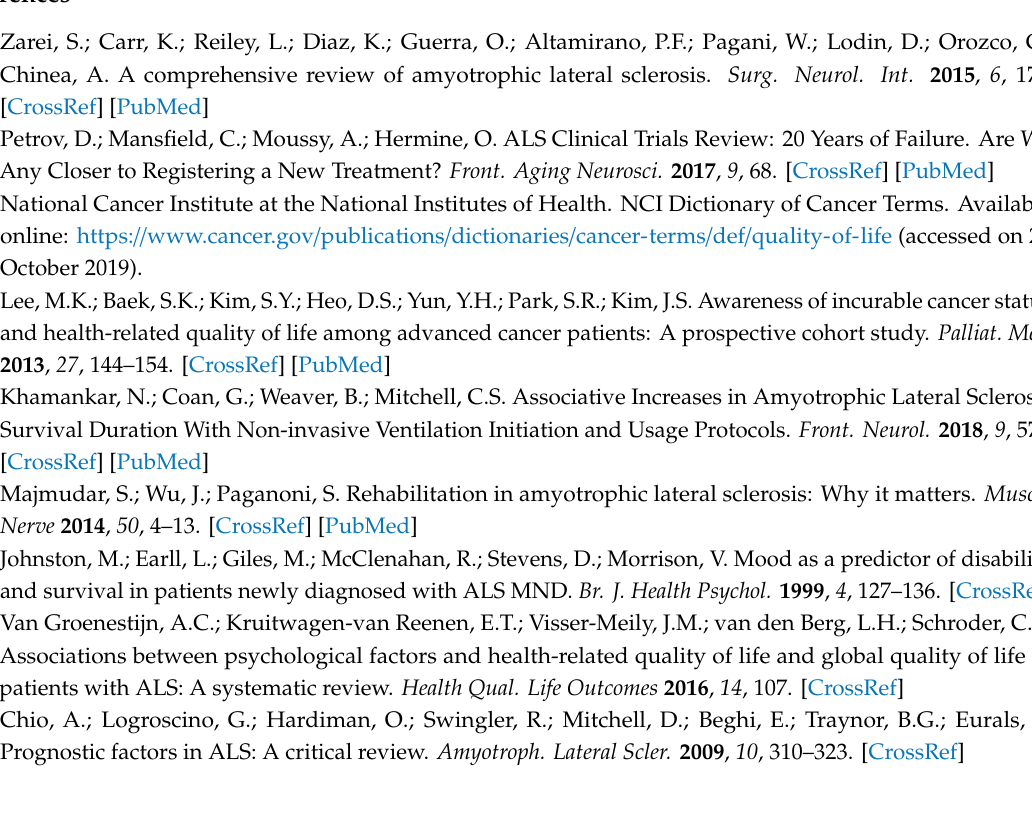
Table S1: Clinical impression of mood (CIM) keyword scoring table. Table S2: Definitions, sample size, and key for the top 8.5% of other pharmaceuticals and supplements. Table S3: Prevalent pharmaceuticals and supplements, which did not have a significant association with survival duration. Figure S1: The Clinical Impression of Mood (CIM) does not have an e ff ect on the number of antidepressants taken by ALS